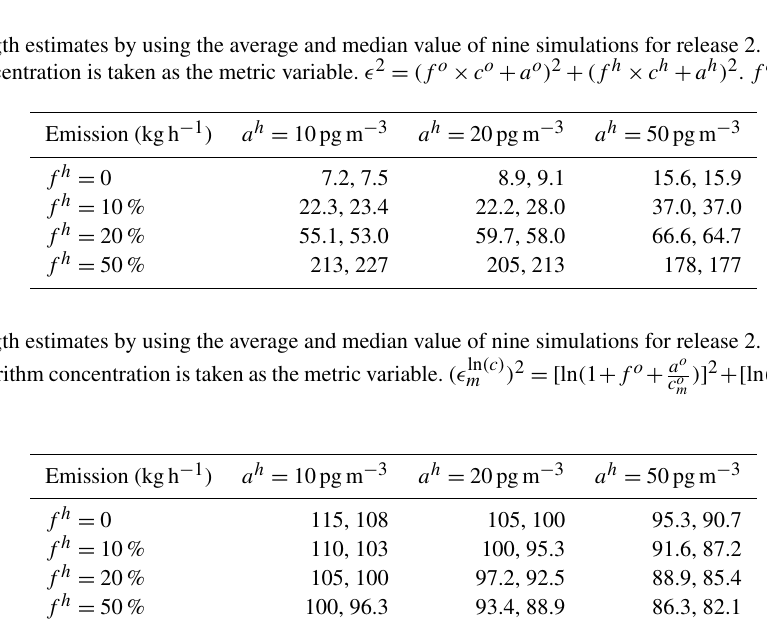
Table 10. Emission strength estimates by using the average and median value of nine simulations for release 2. The cost function is normal- ized F as in Eq. (5). Concentration is taken as the metric variable. (cid:15) 2 = (f o × c o + a o ) 2 + (f h × c h + a h ) 2 . f o = 20%, a o = 20pgm − 3 .